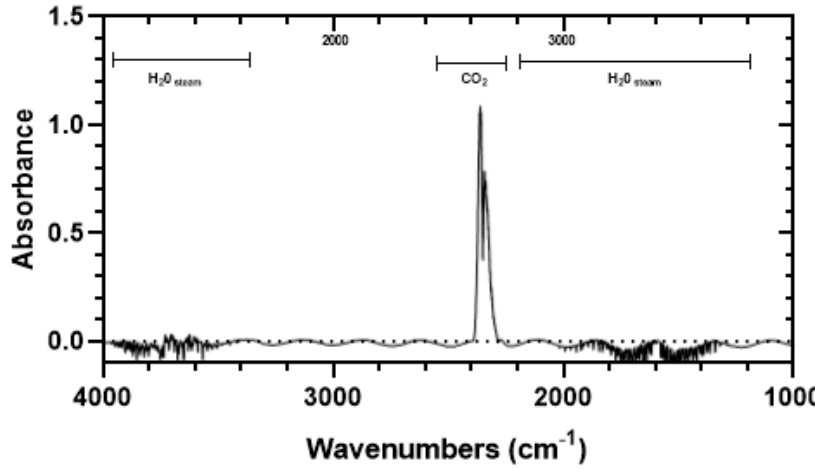
Figure 8. Typical infrared profile of soil gas from the 6 m borehole (Time: 20:03 on 16/Oct/2019). Interferences weak bands of H 2 O vapour are also visible on the spectrum at the low and high-frequency range.